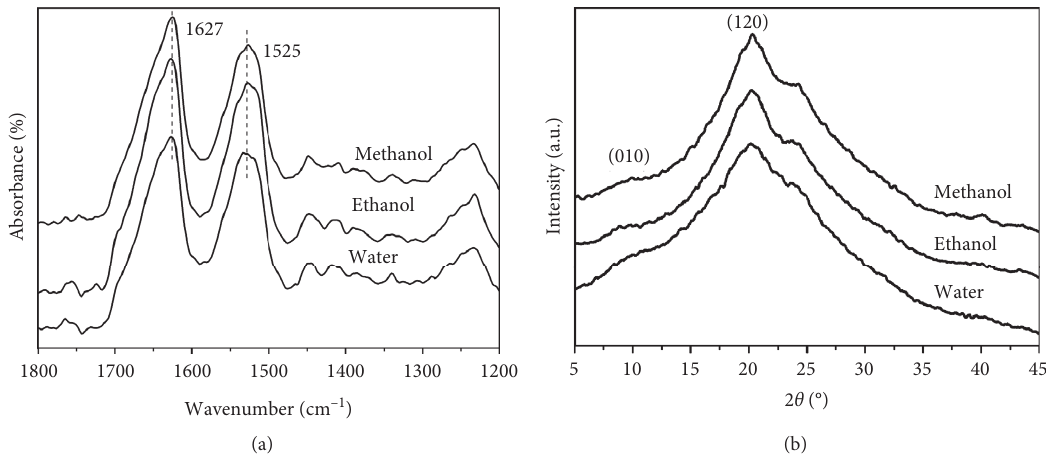
Figure 4: FTIR spectra (a) and XRD spectra (b) of silk scaffolds post-treated with methanol, ethanol, and water.